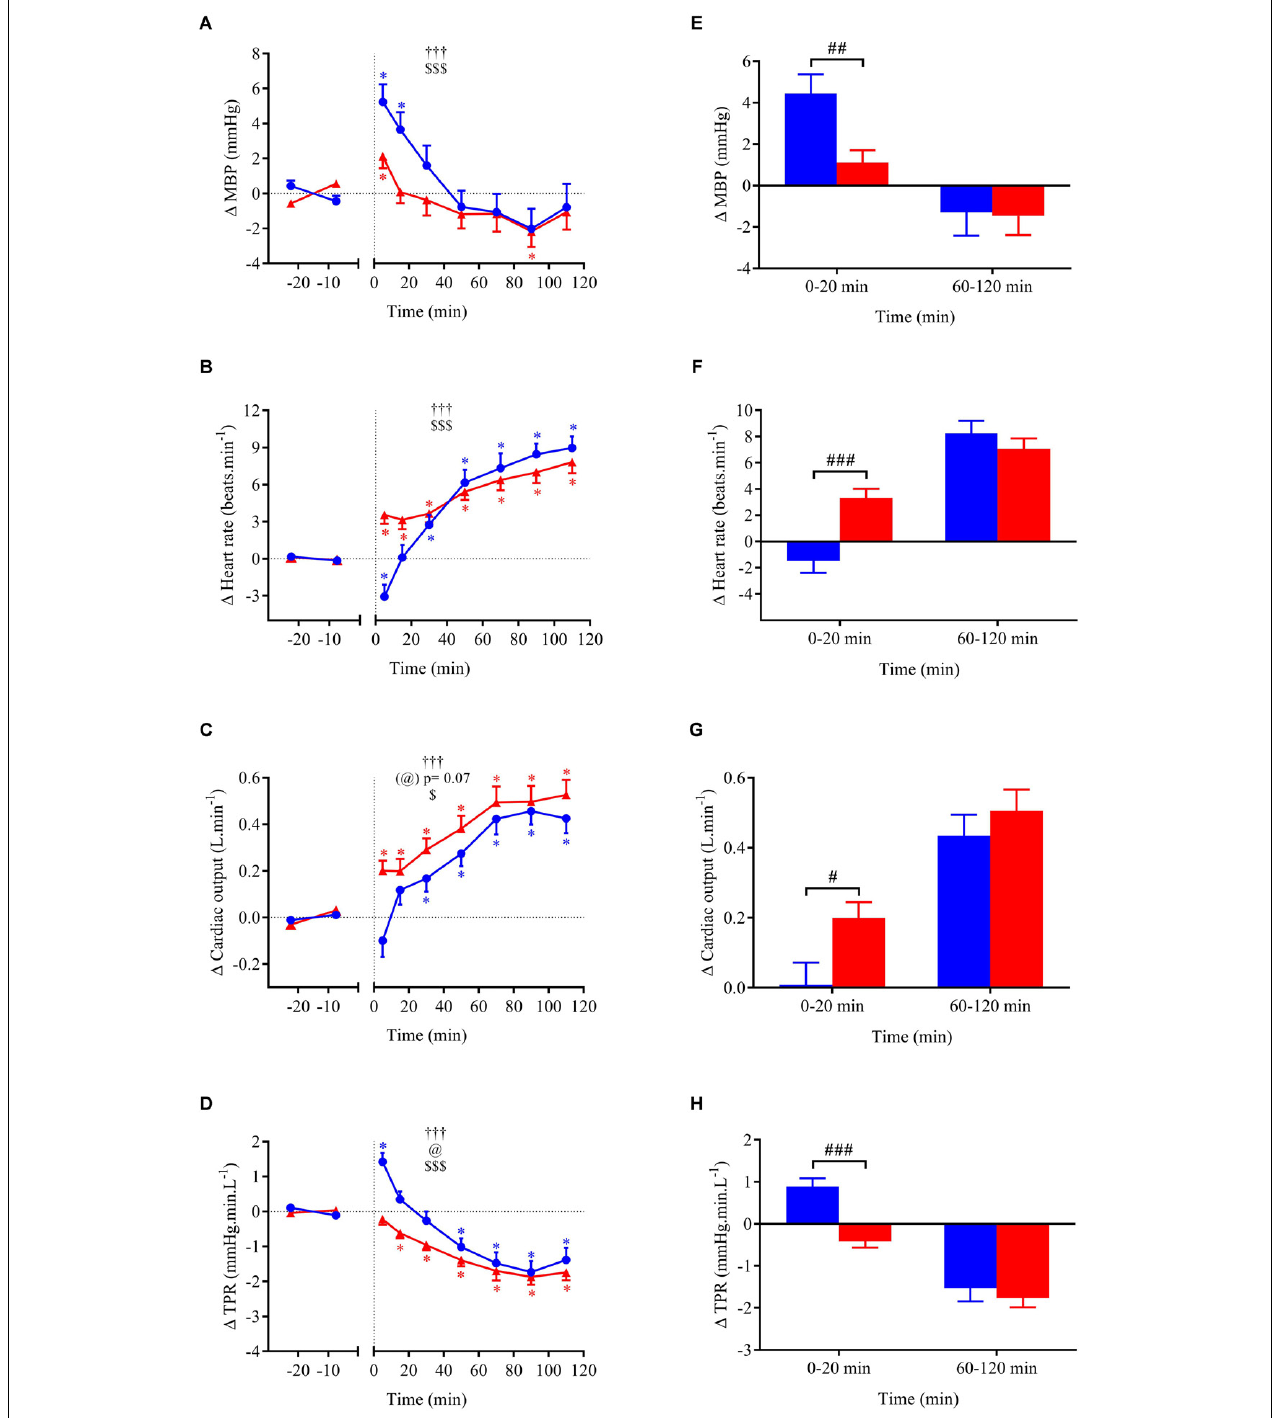
FIGURE 4 | (A–D) Time course of the changes in MBP, heart rate (HR), cardiac output (CO), and total peripheral resistance (TPR) presented as delta (i.e., absolute changes relative to baseline levels). (E–H) Mean responses averaged over 0–20 and 60–120 min post-drink periods presented as delta (i.e., average over 0–20 and 60–120 min post-drink minus the average over the 30-min baseline period, respectively). Drinks: cold wine ( for ANOVA analysis: † , time effect; @, temperature effect; and $, time × temperature interaction effects. ∗ Significant difference over time from baseline values. # Significant difference between drink conditions (cold vs. hot). The level of significance for all symbols was mentioned as follows: one symbol ( p < 0.05), two symbols ( p < 0.01), and three symbols ( p < 0.001).